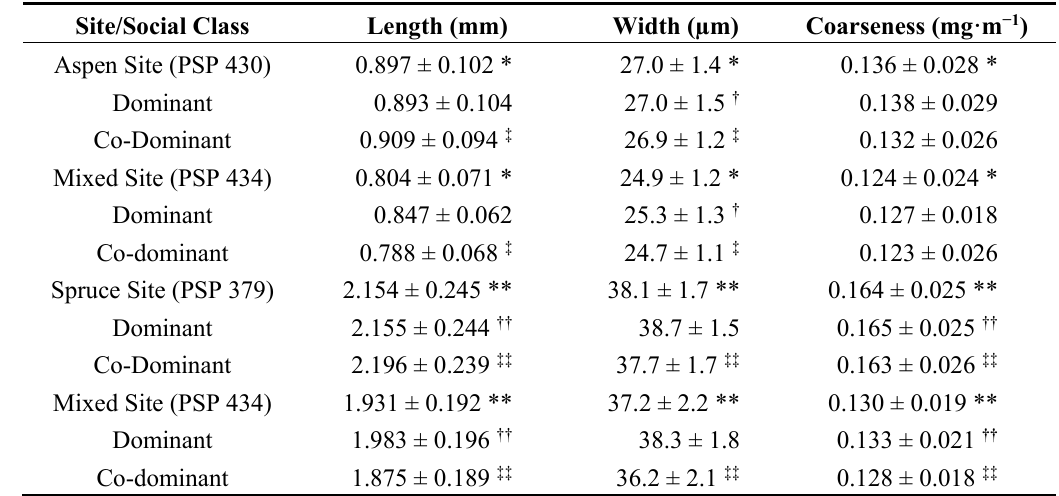
Table 3. Fibre and tracheid length (mm), width (µm) and coarseness (mg·m − 1 ) per site and social class. ( n = 100 samples per